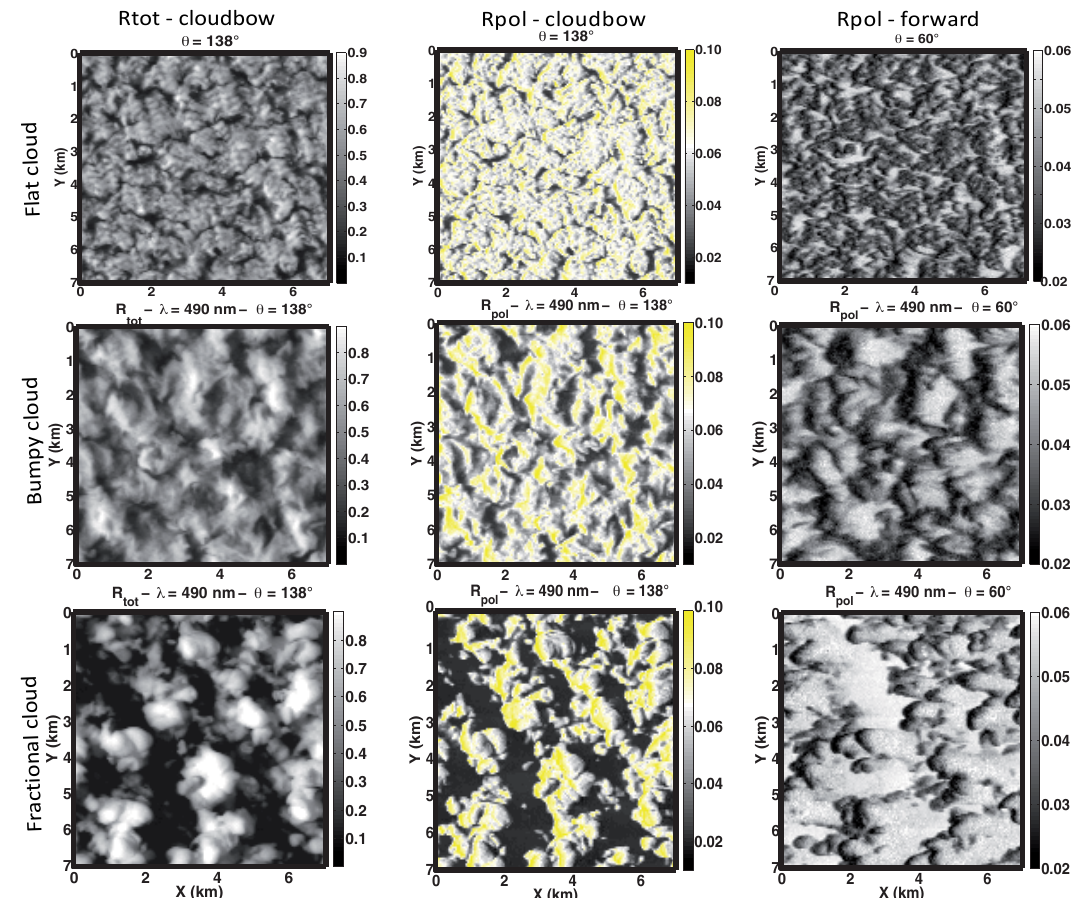
Figure 3. Total and polarized reflectances for the flat cloud (first line), the bumpy cloud (second line) and the fractional cloud (third line). Total reflectances at 490nm in the cloudbow scattering direction (first column), polarized reflectances at 490nm in the cloudbow direction (second column) and polarized reflectances at 490nm in the forward direction (third column). The Sun illuminates the scene from the left of the figures (SZA = 60 ◦ ). For polarized reflectances in the second column, yellow color corresponds to polarized reflectance values higher than the maximum value predicted with the homogeneous cloud